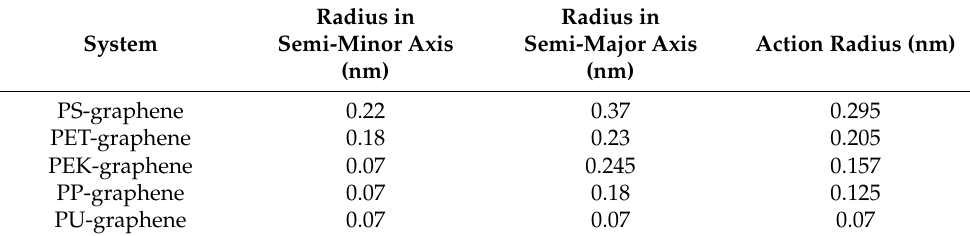
Table 2. Action radius for the polymer–graphene